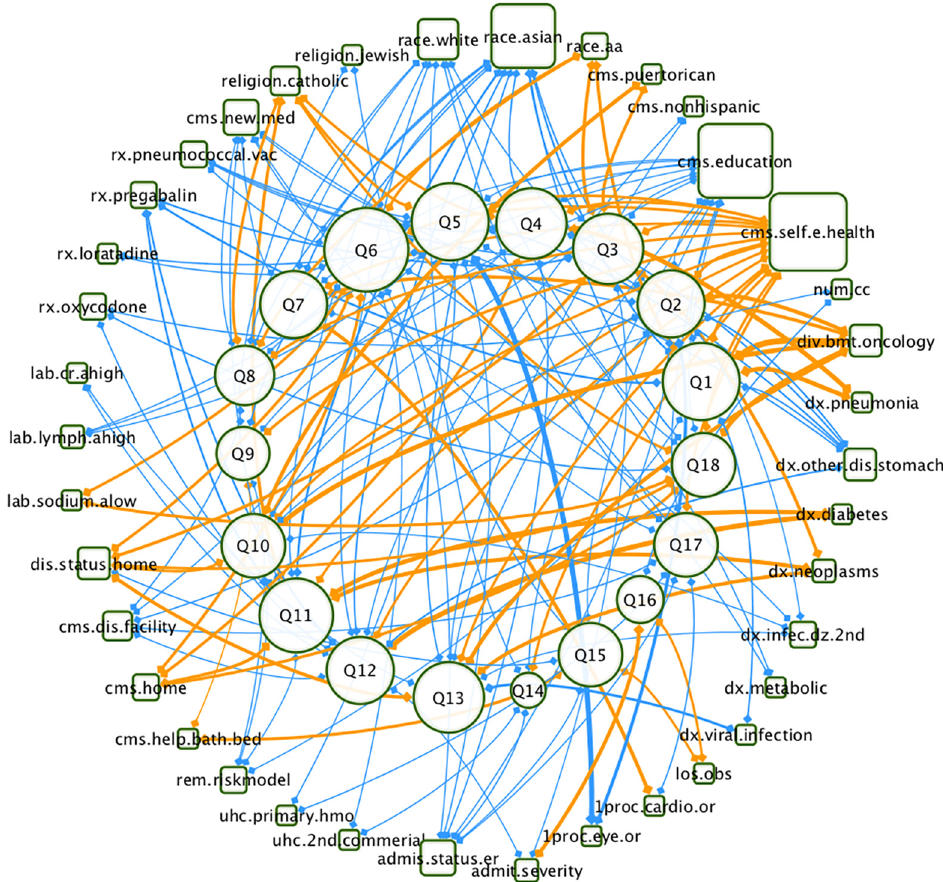
Fig 2. Network of risk factors (selected more than once in risk model profile) to each question. The network consists of the 38 risk factors, which have been selected more than once in risk model profile (Table 1, S3 Table) and 18 questions (S1 Table) with the LASSO algorithm. Risk factors (blue rectangle) and questions (orange circles) are connected by green lines (negative association) or red lines (positive association). The node size reflects the amount of associated risk factors. The edge width and the color grade reflect strength of the odds ratio from the risk model. This network was visualized using Cytoscape